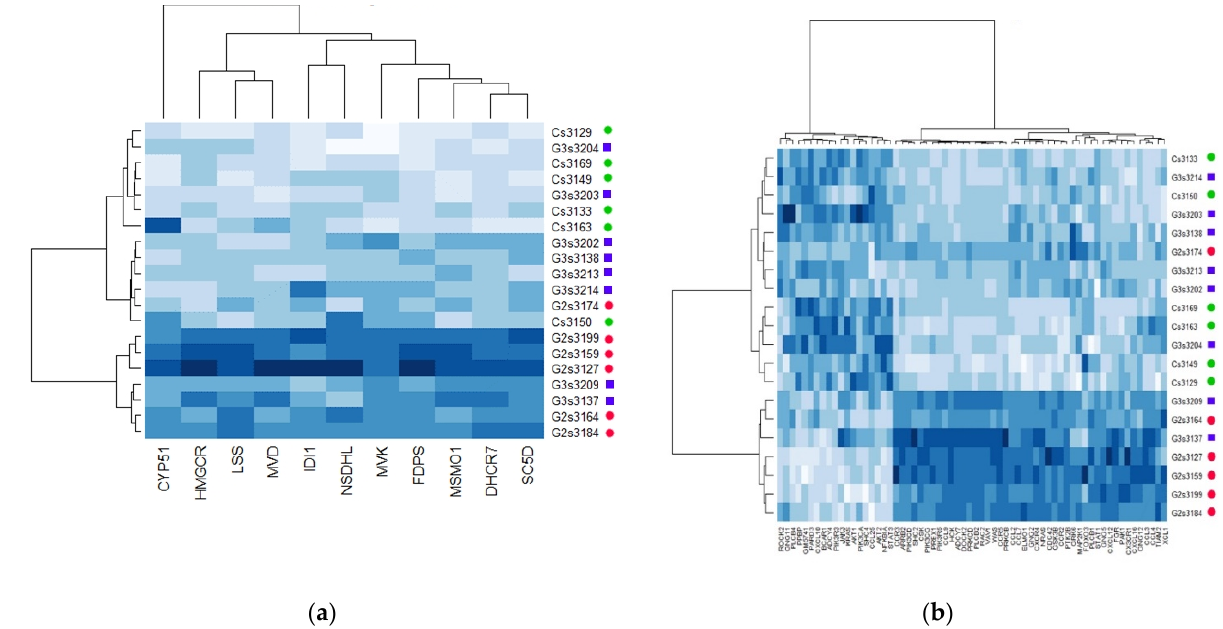
Figure 4. Heatmap displaying the expression level of genes related to cholesterol synthesis ( a ) and chemokine signaling ( b ) in VAT of the 3 groups of mice. Samples from Ref, HFoleic, and HFepa groups are illustrated with green circles, red circles and blue squares, respectively. Heatmap were generated using the correlation-based distance calculation and the ward method as clustering criteria. The magnitude of expression level is represented from white (low) to clear blue (intermediate) and dark blue (high). HFoleic, mice from oleic/control lineage fed with the obesogenic diet; HFepa, mice from EPA/omega 3 lineage fed with the obesogenic diet; Ref, mice from oleic/control lineage fed with the normocaloric diet.